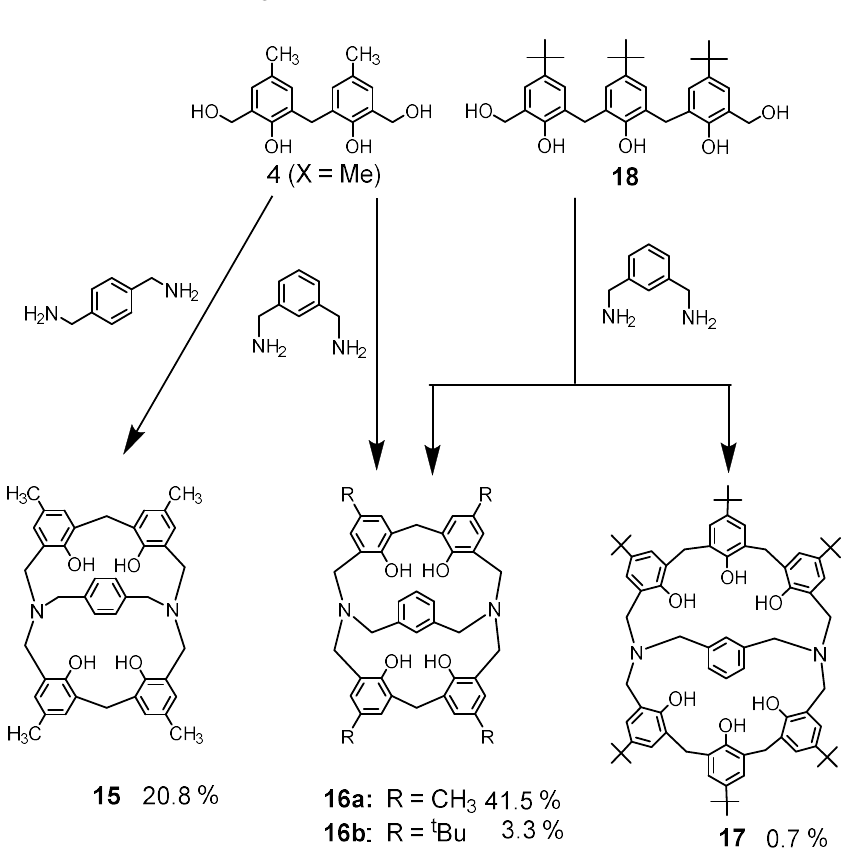
Figure 3. Amino-acid-bridged azacalixarenes.